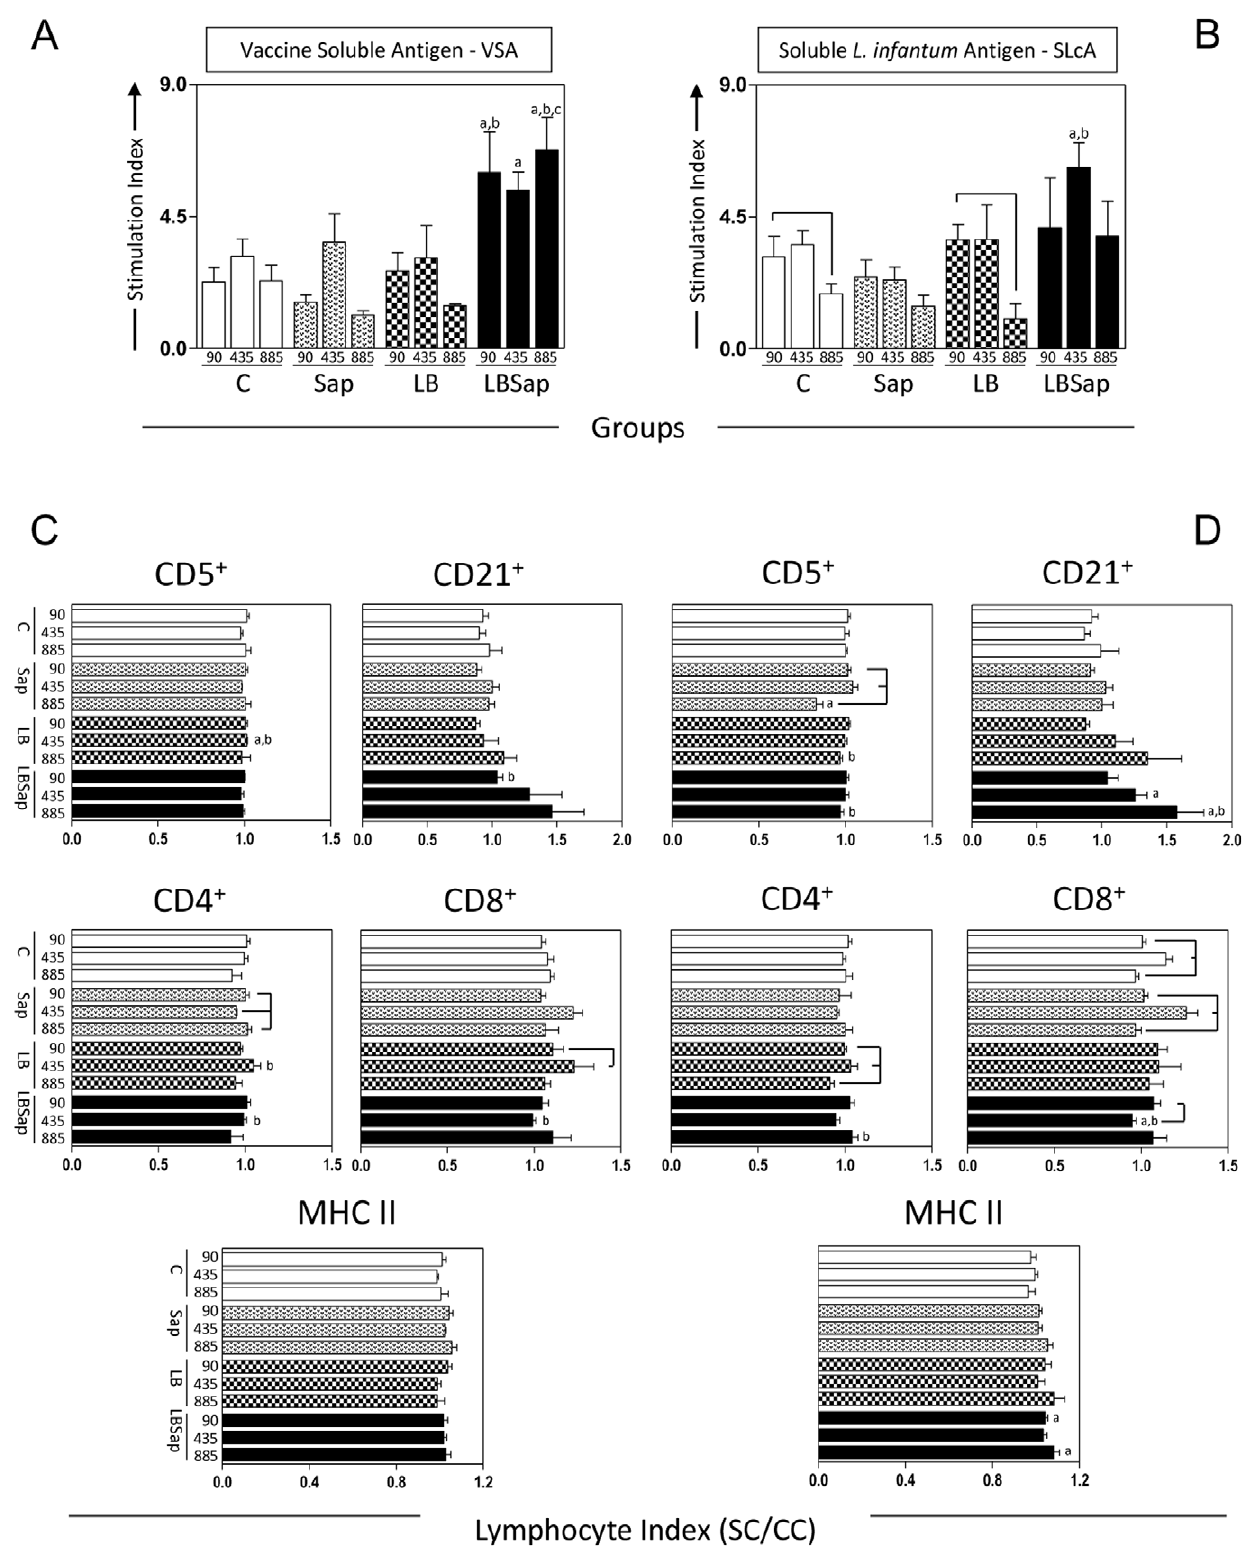
Figure 3. Cell proliferation response of PBMCs after stimulation with (A) vaccine soluble antigen (VSA) and (B) soluble L.infantum antigen (SLcA). The middle and lower panels show the immunophenotypic profile of in vitro peripheral blood mononuclear cells following stimulation with (C) VSA and (D) SLcA determined at 90, 435 and 885 dac (days after challenge with L. infantum plus SGE) for vaccinated groups: C (control; white); Sap (saponin; white with weak hatched); LB (killed L. braziliensis vaccine; white with strong hatched); LBSap (killed L. braziliensis vaccine plus saponin; black). The results are expressed as index (stimulated cultures over non-stimulated cultures (SC/CC)) of the mean frequencies of